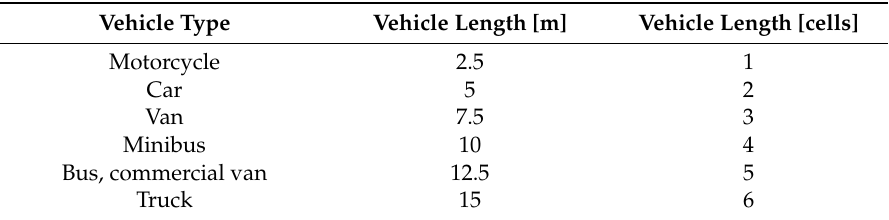
Table 1. Vehicle classification (by length).